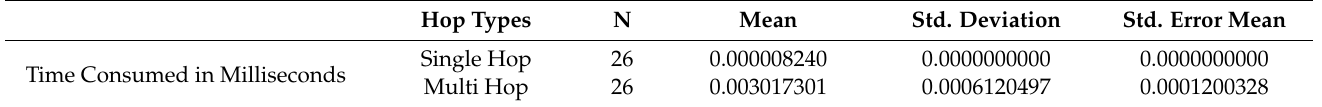
Table 2. Group Statistics.